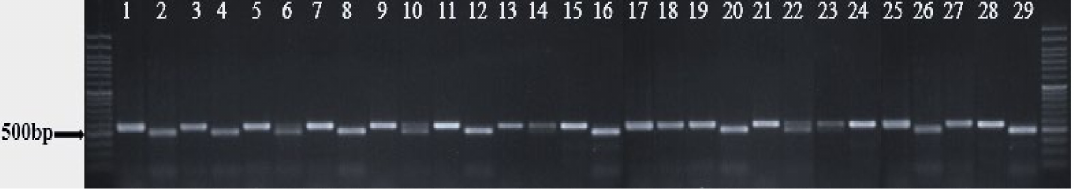
Figure 3. SSR amplification profiles of primer pair LT EST-SSR4 Lane M: DNA molecular standards with length (bp) on left and right. Table 5. Summary of 31 SSR primers results across 29 Lolium genotypes